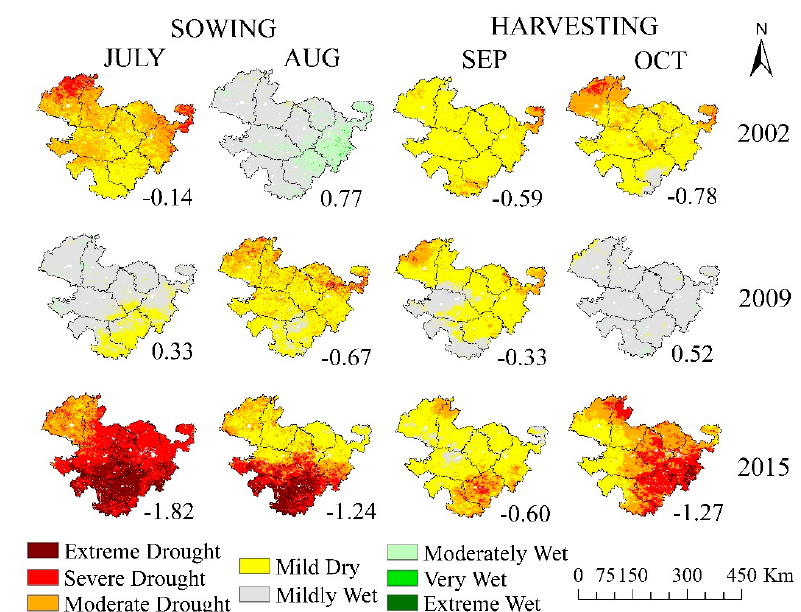
Figure 14. Spatio-temporal representation of CDI_M values over the Kharif season in the Marathwada (bottom right value indicate the monthly average CDI_M over the study area).